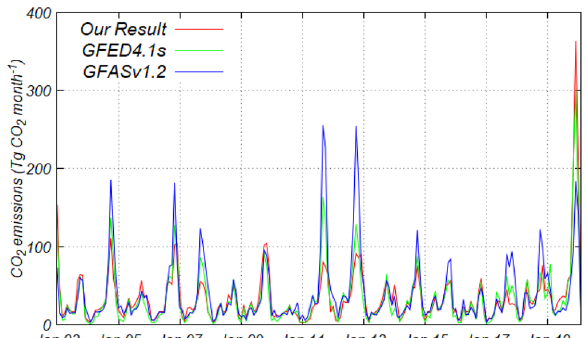
Figure 6. Comparison of monthly CO 2 emissions from fires based on four inventories in AUST region (Fig. S5) from January 2003 to February 2020. The compared inventories are our results (red), GFED4.1 s (green), and GFASv1.2